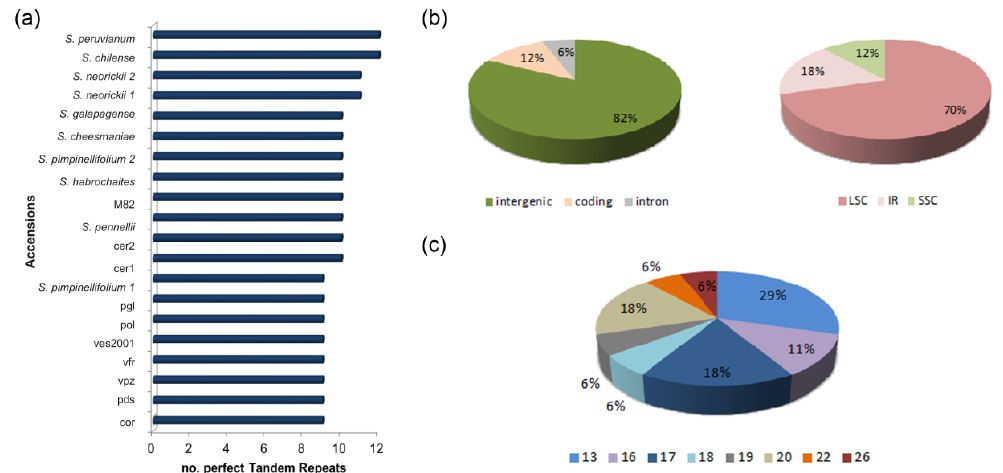
Figure 4. Perfect tandem repeats (TRs) in the nine plastomes sequenced in this work and in the plastome sequence of eleven species available in GenBank. The plastome of IPA-6 (AM087200) was used as reference. ( a ) Bar chart reporting the total number of TRs in each genotype. ( b ) Pie charts describing the percentage of TRs located in the coding sequences of genes, introns, and intergenic regions and in the large single copy (LSC), small single copy (SSC), and inverted repeat b (IR) regions. ( c ) Pie chart describing the percentage of TRs with a specific period size.